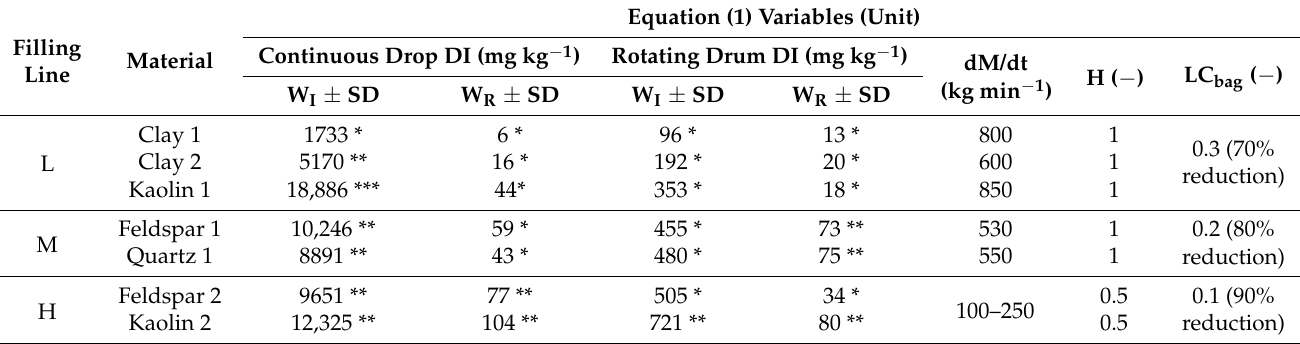
Table 1. Variables used in Equation 1. Dustiness index (CD and RD) for material, calculated dM/dt, H factor and LC due to the effect of enclosure of the